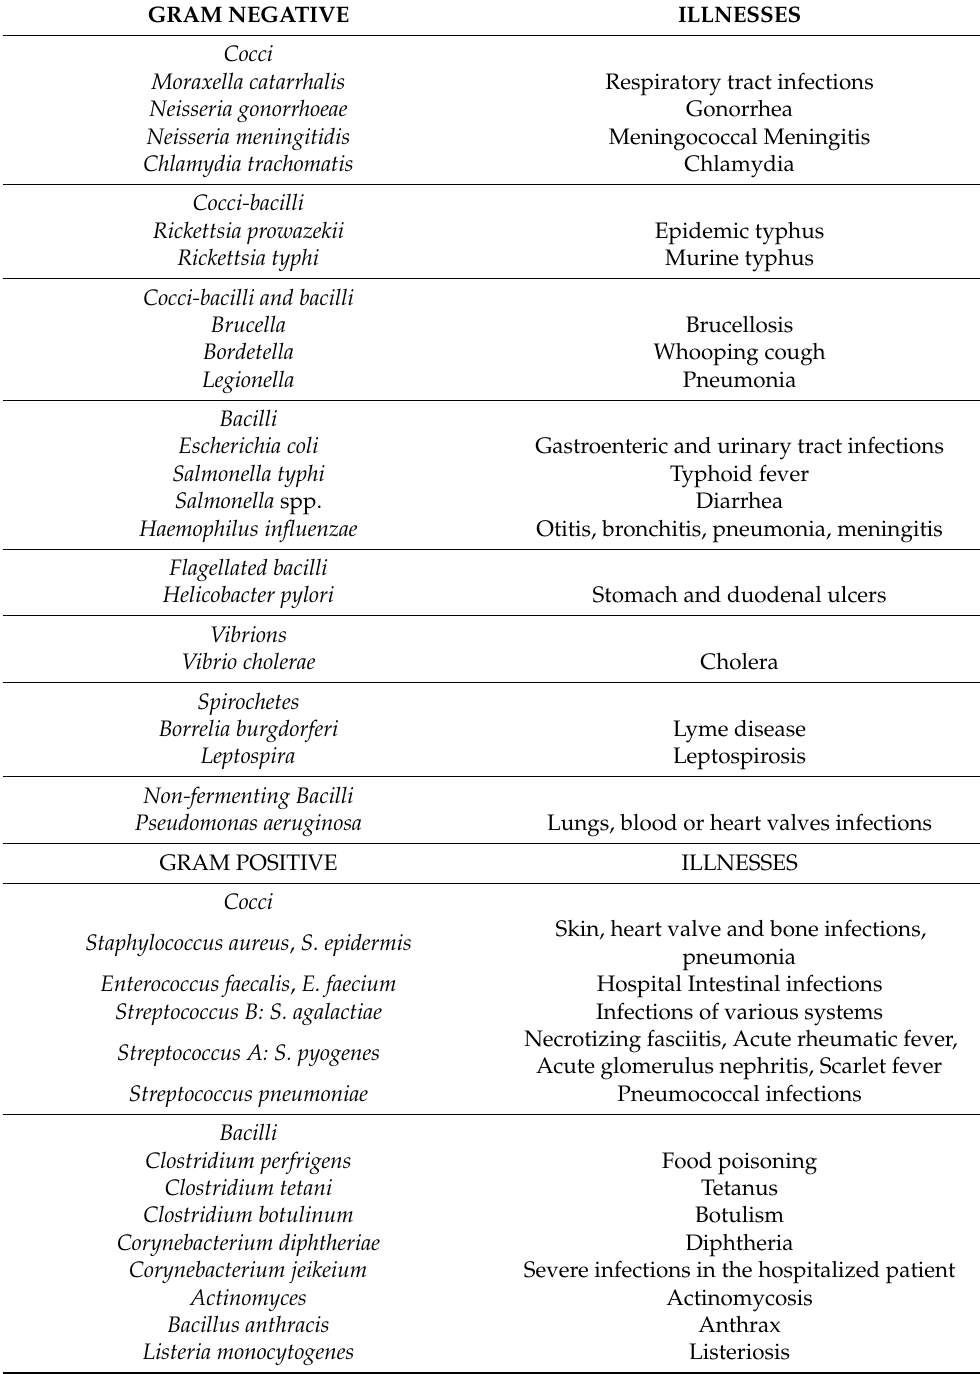
Table 1. Pathogenic bacteria and their associated infections. Examples of gram-negative and gram- positive pathogenic bacteria and their associated